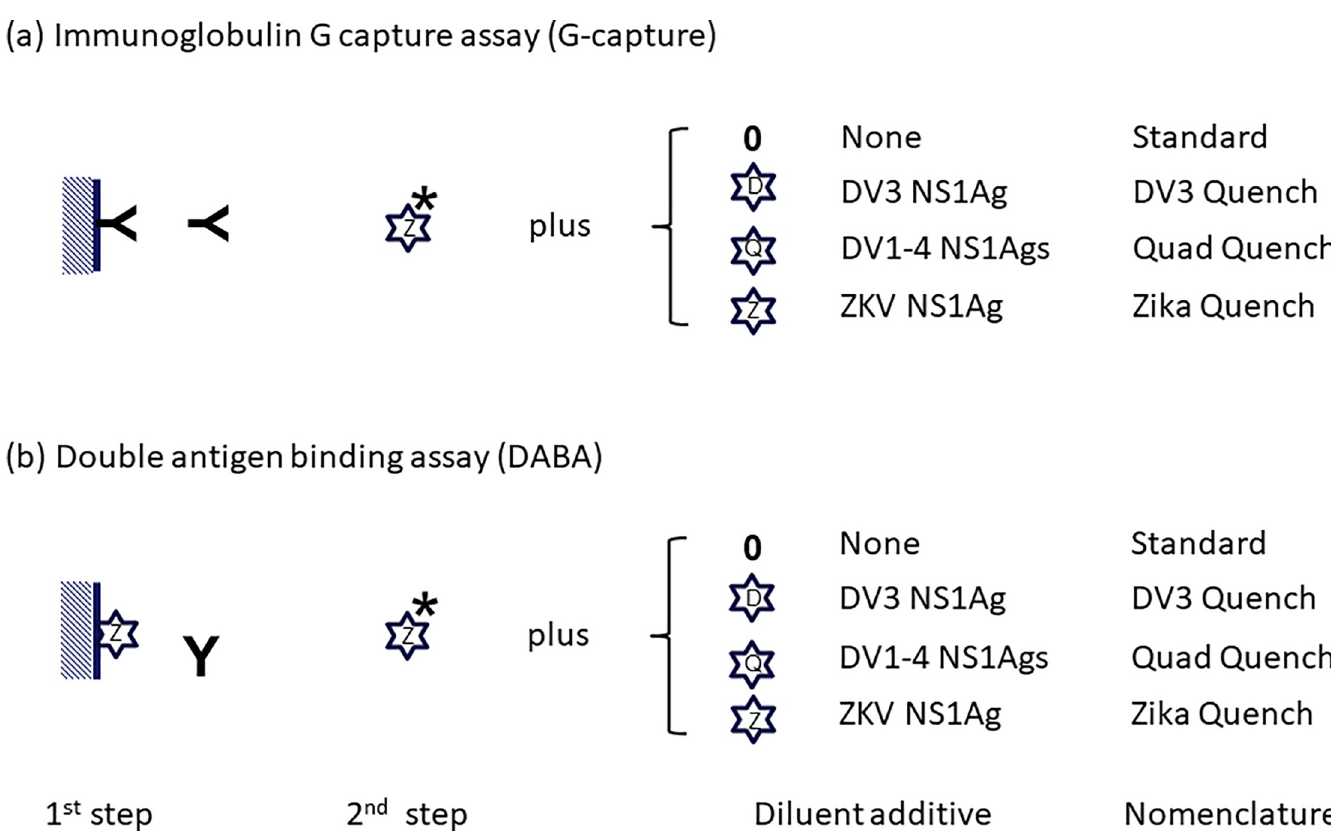
Fig 1. Illustration detailing the immunoglobulin G capture assay (G capture) and the double antigen binding assay (DABA). The G Capture solid phase (cross hatched) is coated with rabbit anti-human gamma FC to capture G from the clinical sample in the first step of the assay. After washing, conjugate is applied and specific antibody ( Y ) revealed by ZIKA virus NS1 antigen (ZKVNS1Ag) labelled with horseradish peroxidase (HRPO; Z � , standard). The DABA solid-phase is coated with ZKVNS1Ag to capture antibody to NS1Ag of any class. After washing, conjugate is applied and bound antibody ( Y ) revealed by ZKV NS1Ag labelled with HRPO as